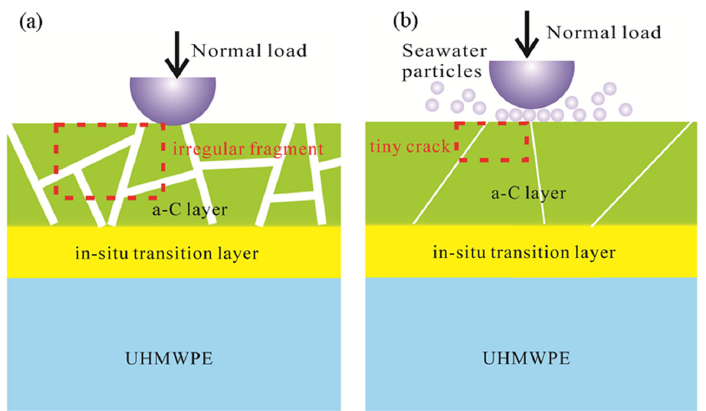
Figure 16. The good protection mechanism of in situ growth of a-C on UHMWPE during sliding wear: ( a ) under dry friction, ( b ) under artificial seawater friction.